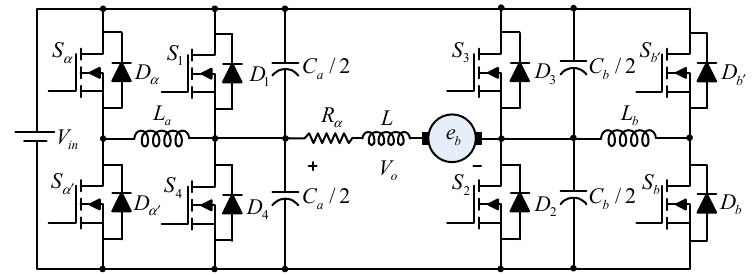
Figure 16. 4Q-ZVT converter fed DC motor drive .